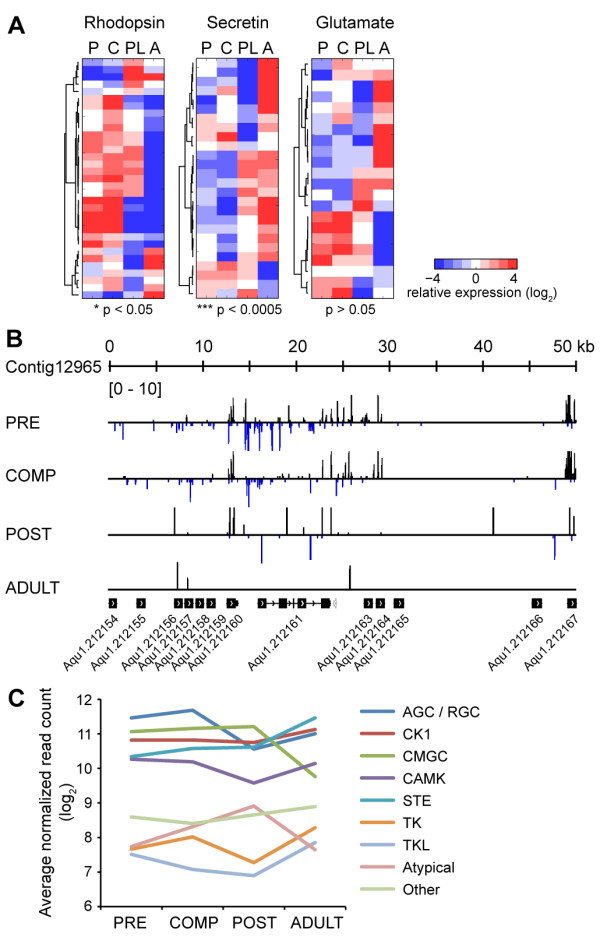
Expression of G-protein coupled receptors and kinases. (A) Relative expression of members of GPCR families defined in a previous study [23] across A. queenslandica developmental stages (red, high; blue, low). Stage enrichment of genes was estimated using Fisher’s exact test (p-values shown). (B) Gene contig with a cluster of 13 rhodopsin family GPCR genes (gene organization is indicated at the bottom). Reads mapping to the plus (black) and minus (blue) strands of this genomic locus in the four developmental stages are shown (reads normalized to 10 million, maximum peak height shown is 10 reads). A non-GPCR gene in the cluster is shown in gray. (C) Average normalized read counts for members of kinase classes defined in a previous study [23].